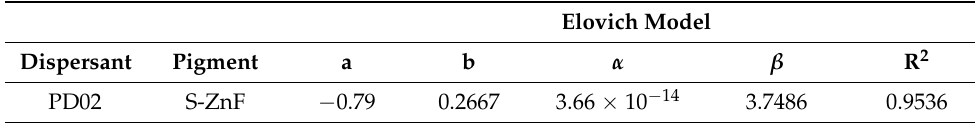
Table 7. The Elovich model parameters for dispersant PD02 adsorbed on the surface of the S-ZnF particles.